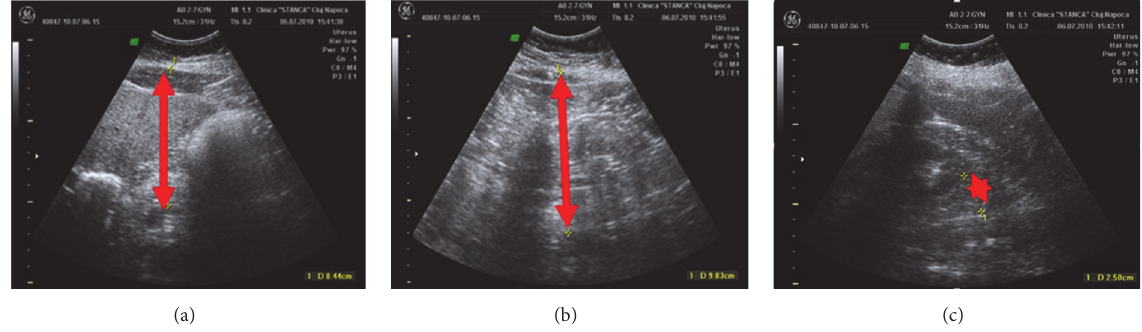
Figure 1: (a) Distance between the inner side of the right abdominal muscle and the splenic vein. (b) Distance between the inner side of the right abdominal muscle and the posterior wall of the aorta. (c) Fat thickness in the posterior wall of the right